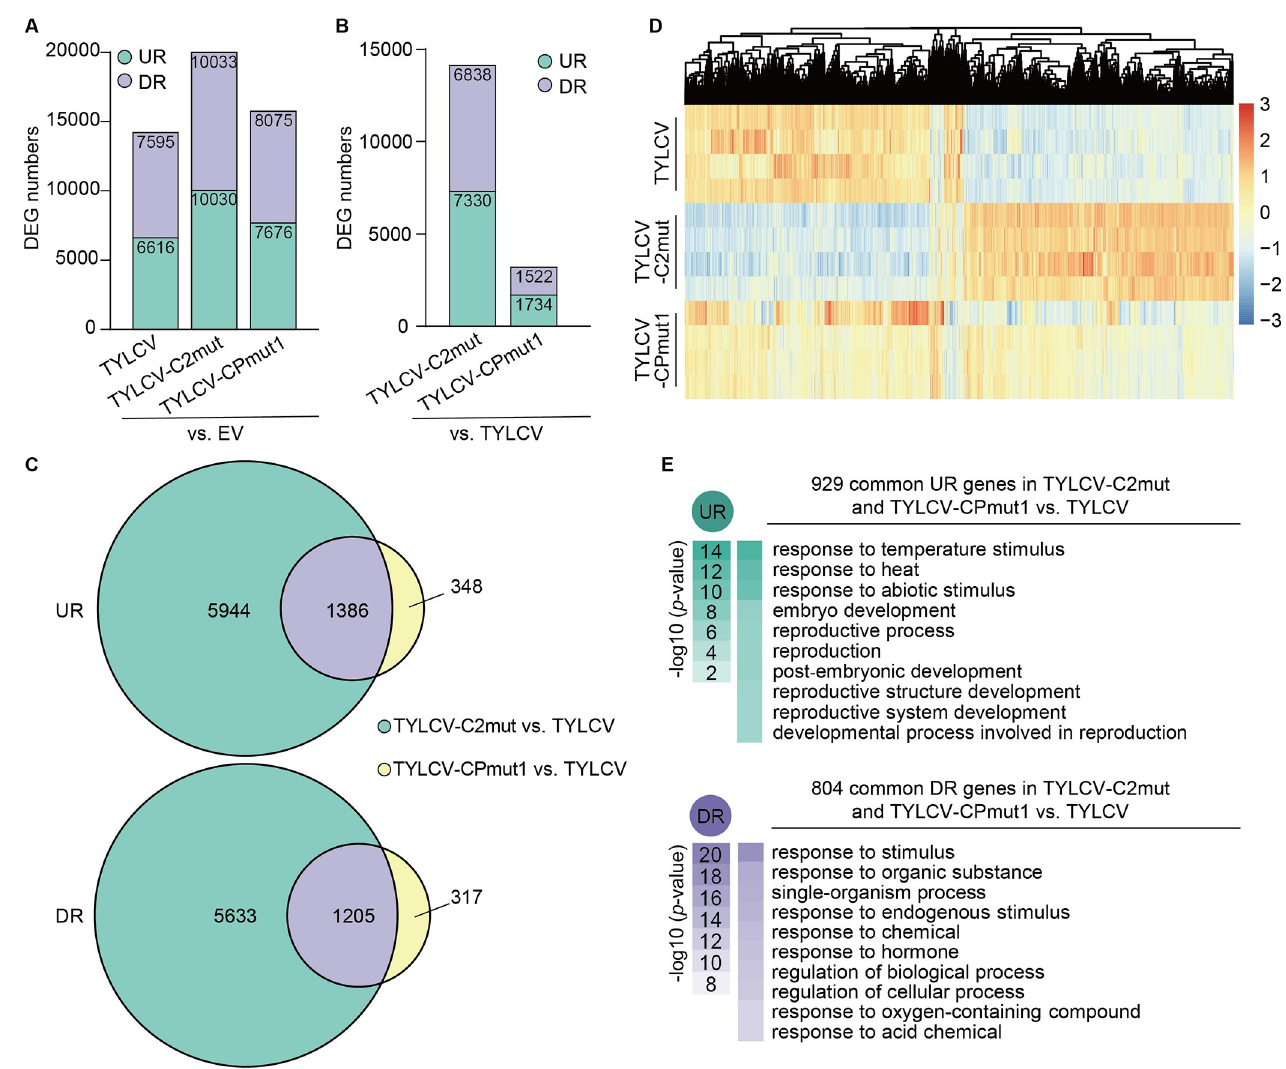
Fig 6. C2 and CP functionally interact in planta in the context of the viral infection. (A, B) Number of differentially expressed genes (DEGs) upon infection by TYLCV WT or C2-null or CP-null mutant variants (TYLCV-C2mut and TYLCV-CPmut1, respectively) in N . benthamiana leaves compared to the empty vector control (A) , or to TYLCV WT (B) . UR: up-regulated; DR: down-regulated; EV: empty vector. Full lists can be found in S2 Table. (C) Venn diagrams of DEGs upon infection by TYLCV C2-null and TYLCV CP-null mutants (TYLCV-C2mut and TYLCV-CPmut1, respectively) compared to TYLCV WT. UR: up-regulated; DR: down-regulated. (D) Heatmap with hierarchical clustering from (A) . The colour scale indicates the Z-score. (E) Functional enrichment analysis of the subsets of up-regulated (UR) or down-regulated (DR) genes in the indicated samples. Gene Ontology (GO) categories from the Biological Process ontology enriched with a p- value < 0.01 (up to top 10) are shown; functional enrichment was performed using the orthologues in A . thaliana . The colour scale indicates the -log10 ( p -value), showing the significance of GO term enrichment. For a full list, see S4 Table. See also S8 and S9 Figs; S2 and S4